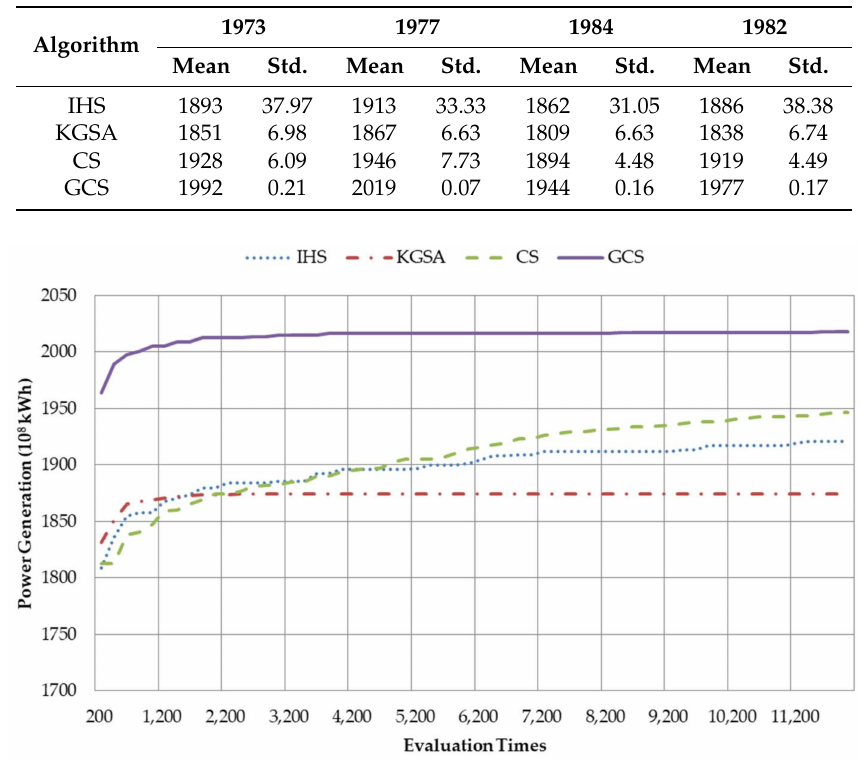
Figure 12. Convergence process of the algorithms in year